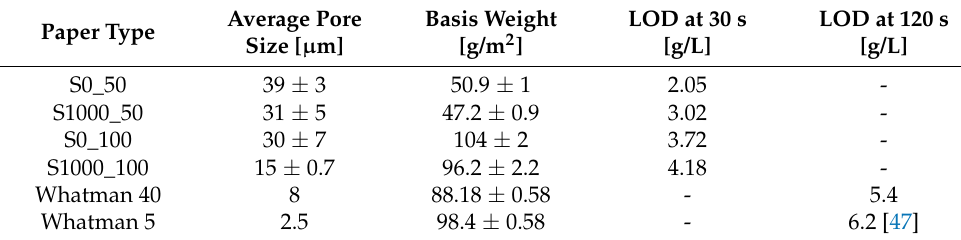
Table 6. Measured limit of detection for different paper substrates. Paper